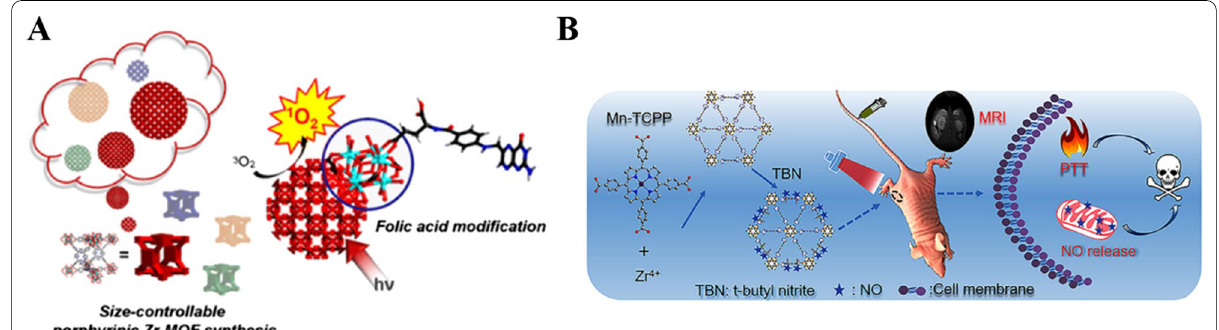
Fig. 2 A Illustration of PCN-224 structure. 6-connected Zr 6 cluster (Zr 6 O 4 (OH) 4 (H 2 O) 6 (OH) 6 (COO) 6 ), tetratopic linker (tetrakis (4-carboxyphenyl) porphyrin (H 2 TCPP)), and 3D nanoporous framework of PCN-224. (b) A cubic unit of PCN-224 and schematic illustration of spherical PCN-224 nanoparticles on the basis of construction of cubic units, yielding different sizes [39]. Copyright 2018 American Chemical Society. B Scheme for the synthesis of the NMOF–SNO nanocomposite and the NIR light-triggered NO release and PTT [42]. Copyright 2018 American Chemical